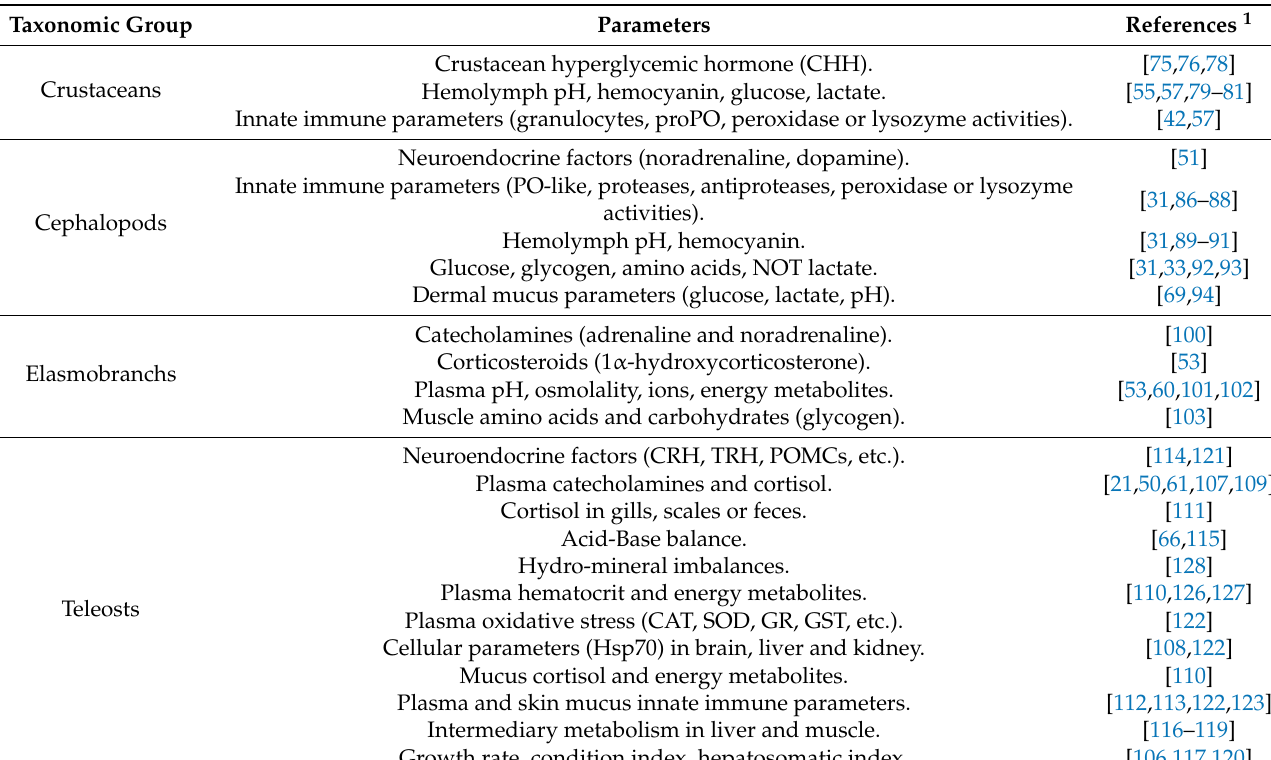
Table 2. Summary of selected useful physiological parameters to assess stress responses and welfare of aquatic animals among different taxa (crustaceans, cephalopods, elasmobranchs, teleosts, and dipnoans). Taxonomic